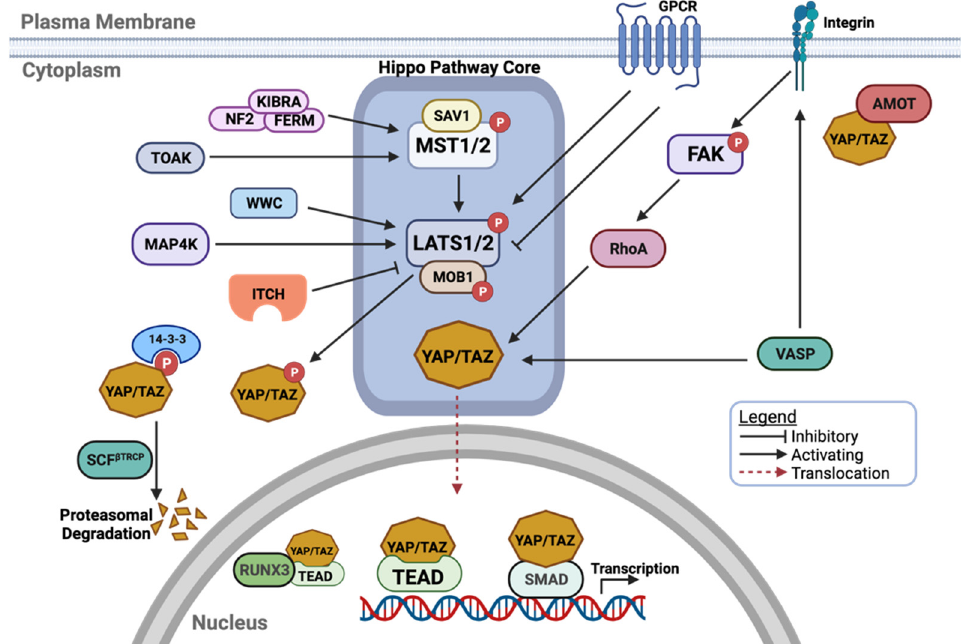
Figure 1. Schematic diagram of the Hippo signalling pathway. The canonical core kinase cassette is composed of the kinases MST1/2 and LATS1/2, the adaptor proteins MOB1 and SAV and the tran- scriptional co-factors YAP and TAZ. MST1/2 phosphorylates LATS1/2, that in turn phosphorylates and inactivates YAP. Phosphorylated YAP is sequestered by the 14-3-3 protein in the cytoplasm and degraded via proteasome facilitated by the SCF β TRCP E3 ligase. Other non-canonical regulators have been discovered to modulate the Hippo pathway core. The KIBRA–NF2–FERM complex and TOAK has been identified to play an activating role on MST1/2. WWC is an adaptor protein that binds and activates LATS while MAP4K may phosphorylate LATS directly. ITCH is a E3 ligase that promotes ubiquitination and proteasomal degradation of the LATS. AMOT directly binds to YAP/TAZ to promote YAP/TAZ cytoplasmic sequestration and phosphorylation. Integrin signalling is another non-canonical pathway that activates YAP through FAK/RhoA and VASP. Additionally, VASP can stabilise YAP/TAZ by inducing its dephosphorylation. YAP/TAZ associates with